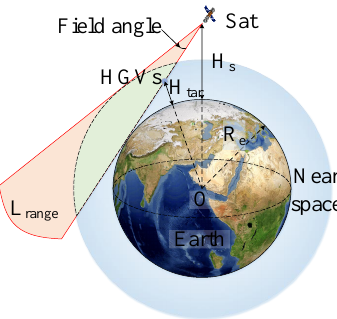
Figure 2. Detection range of infrared sensors.